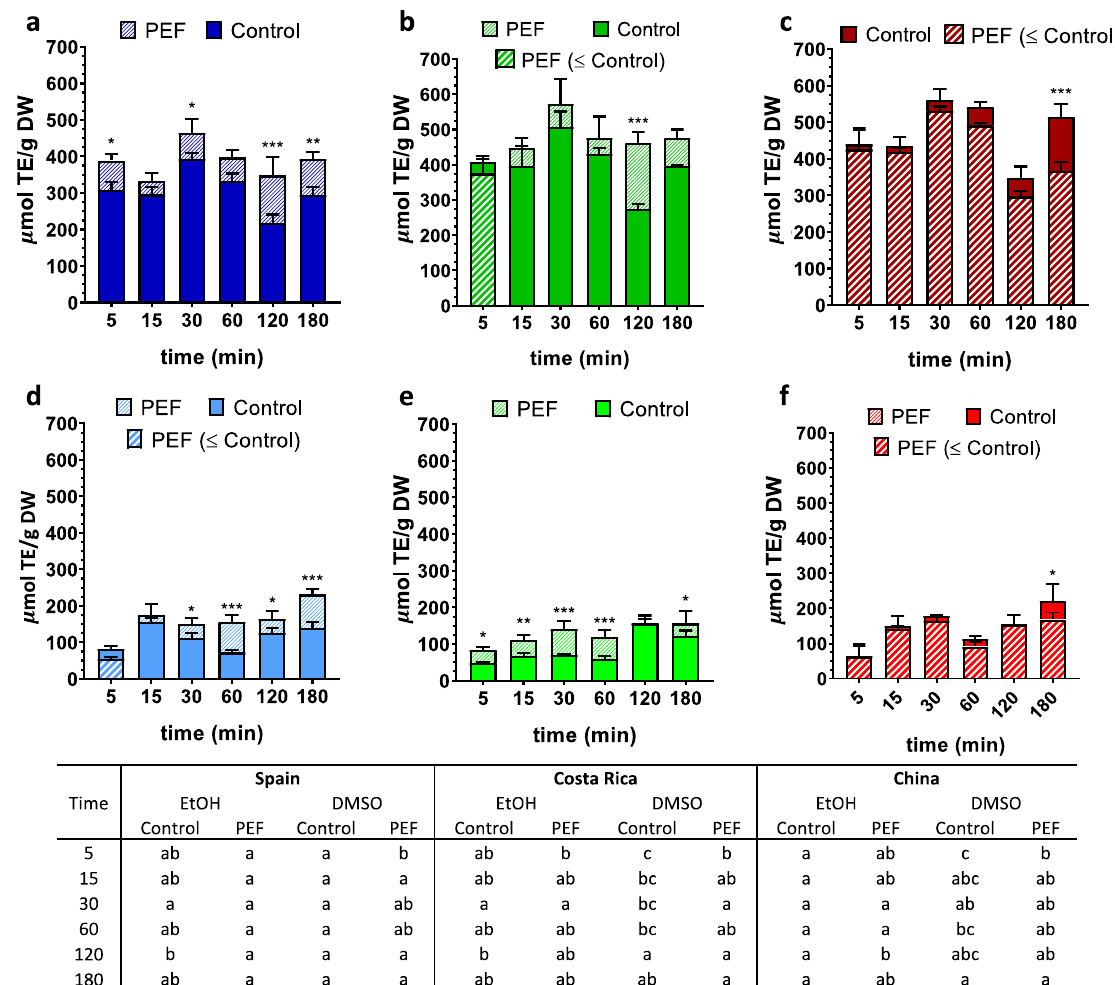
Figure 6. Oxygen radical antioxidant capacity of Spirulina extracts with PEF treatment or without PEF treatment (Control) for ethanol:water ( a – c ) and DMSO:water ( d – f ) solvent from Spirulina cultivated in different geographical regions (blue: Spain, green: Costa Rica, red: China). Statistical differences related to the PEF treatment are represented by asterisks (*). Statistical differences related to the extraction time are represented by different lower-case letters in the table. * p < 0.05; ** = p < 0.01; *** = p < 0.001.